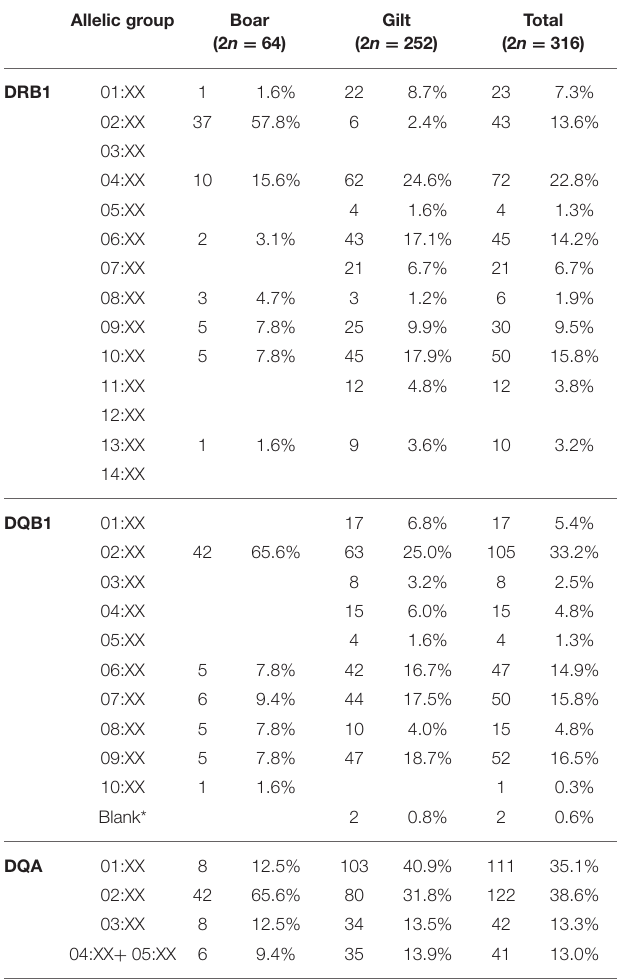
TABLE 3 | Frequency of SLA class II allelic groups. Allelic